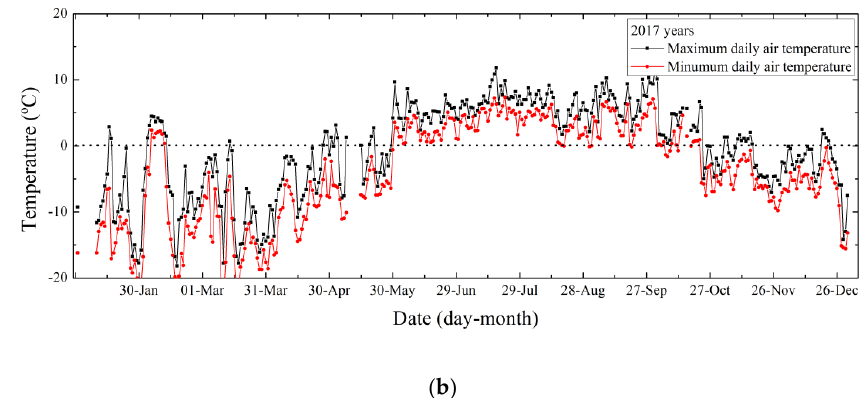
Figure 4. Minimum and maximum daily air temperature variation measured at Dasan station at Ny-Ålesund of years ( a ) 2015 (maximum freeze-thaw cycles of 62) and ( b ) 2017 (minimum freeze-thaw cycles of 33).